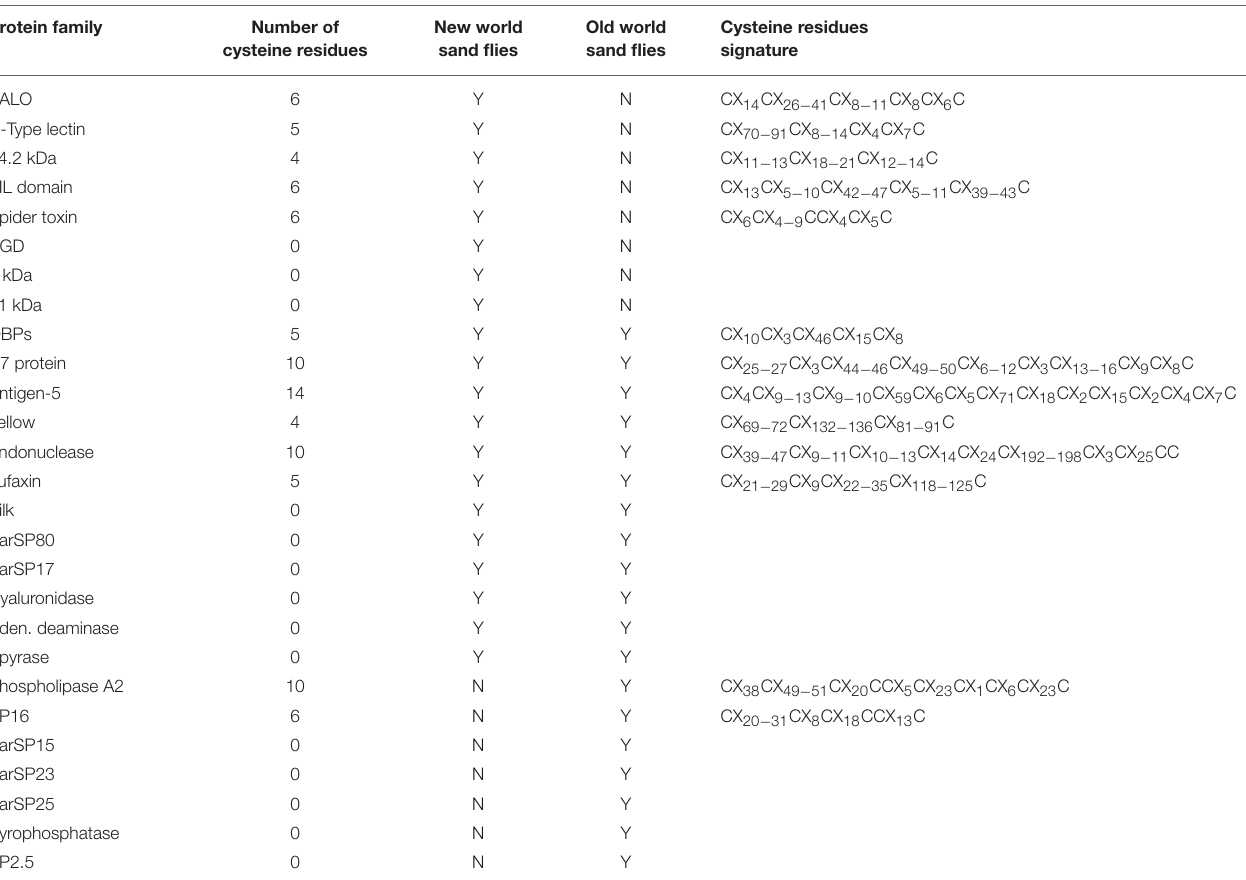
TABLE 2 | Cysteine residue signatures of the sand fly salivary protein families. Protein family Number of